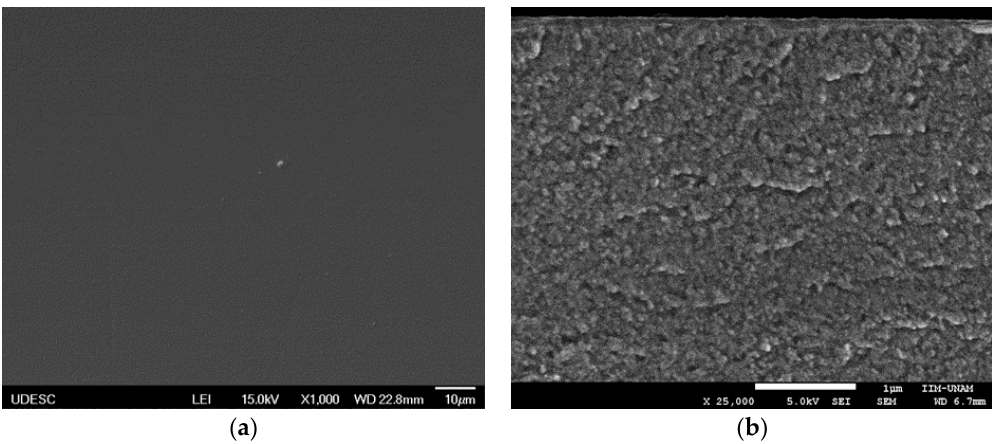
Figure 3. Scanning electron microscopy (SEM) micrographs of Ar4Ag films: ( a ) surface; ( b ) cross-section.